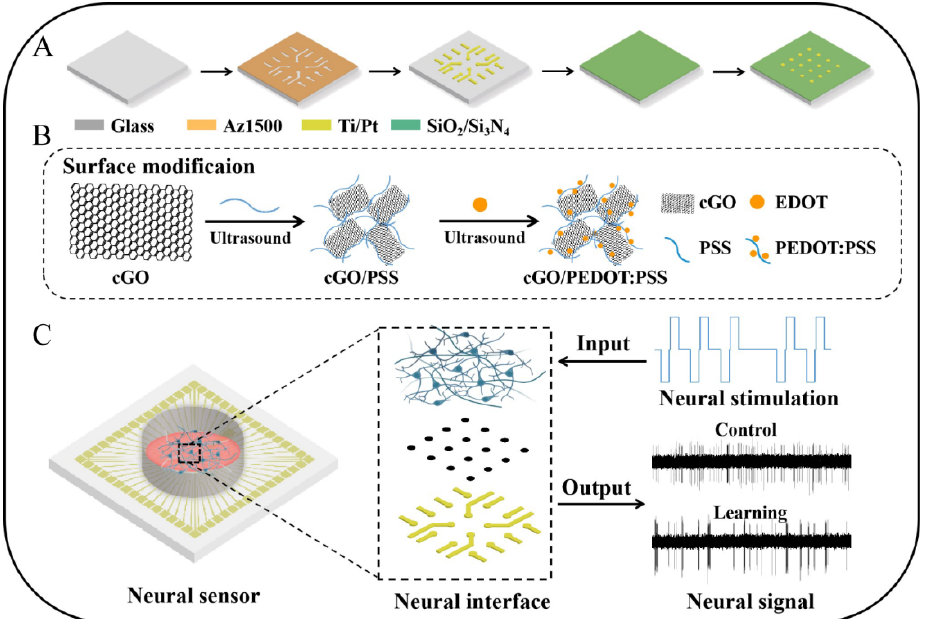
Figure 1. Fabrication and mechanism of the neural sensor. ( A ) Manufacturing process of the neural sensor. ( B ) Modification of the neural interface with nanocomposites. ( C ) Working principle of the sensor. Neurons can grow on the neural sensor, where the interface is the core component. Through the vital link, the integrated system can process the input stimulation information and output corresponding neural signals.